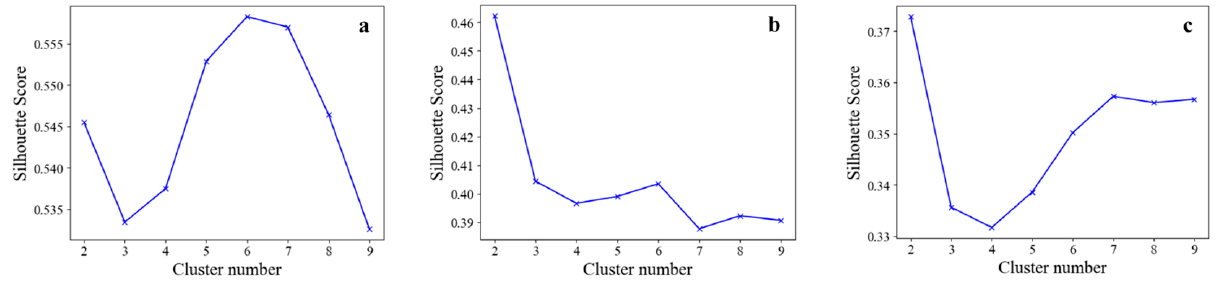
Figure 4. Results of the optimal cluster number selection in Hebei’s bedrooms (( a ). Early heating period; ( b ). mid heating period; ( c ). late heating period).